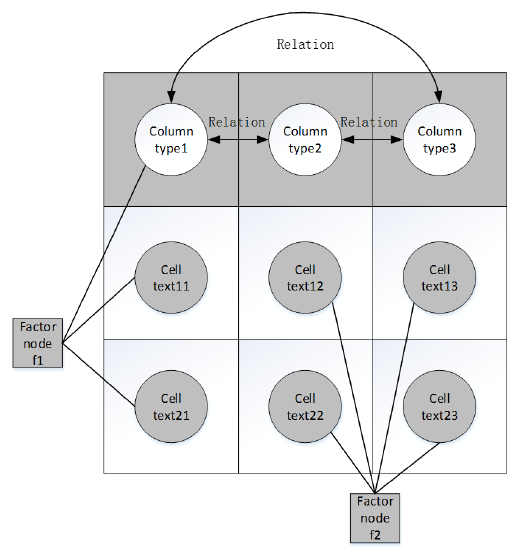
Figure 7. Factor graph of a given relational table.